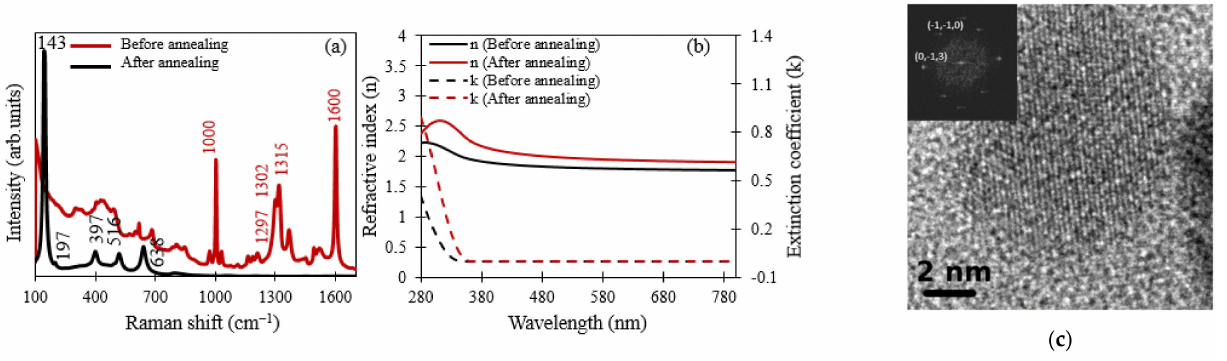
Figure 2. ( a ) Raman spectra. ( b ) Refractive index and extinction coefficient of the film before and after annealing at 500 ◦ C. ( c ) HRTEM micrograph of an anatase TiO 2 nanocrystallite (inset: the corresponding FFT showing the ( − 1, − 1, 0) and (0, − 1, 3) directions of the anatase TiO 2 tetragonal